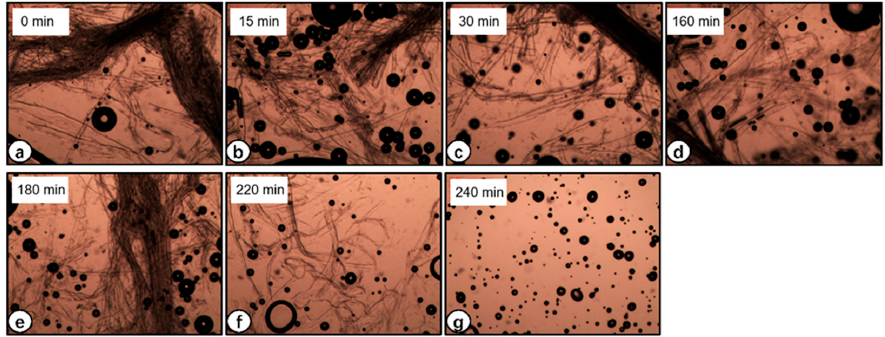
Figure 2. Optical micrographs of sisal fibers samples hydrolyzed in H 3 PO 4 : ( a ) 0 min; ( b ) 15 min; ( c ) 30 min; ( d ) 160 min; ( e ) 180 min; ( f ) 220 min; ( g ) 240 min.